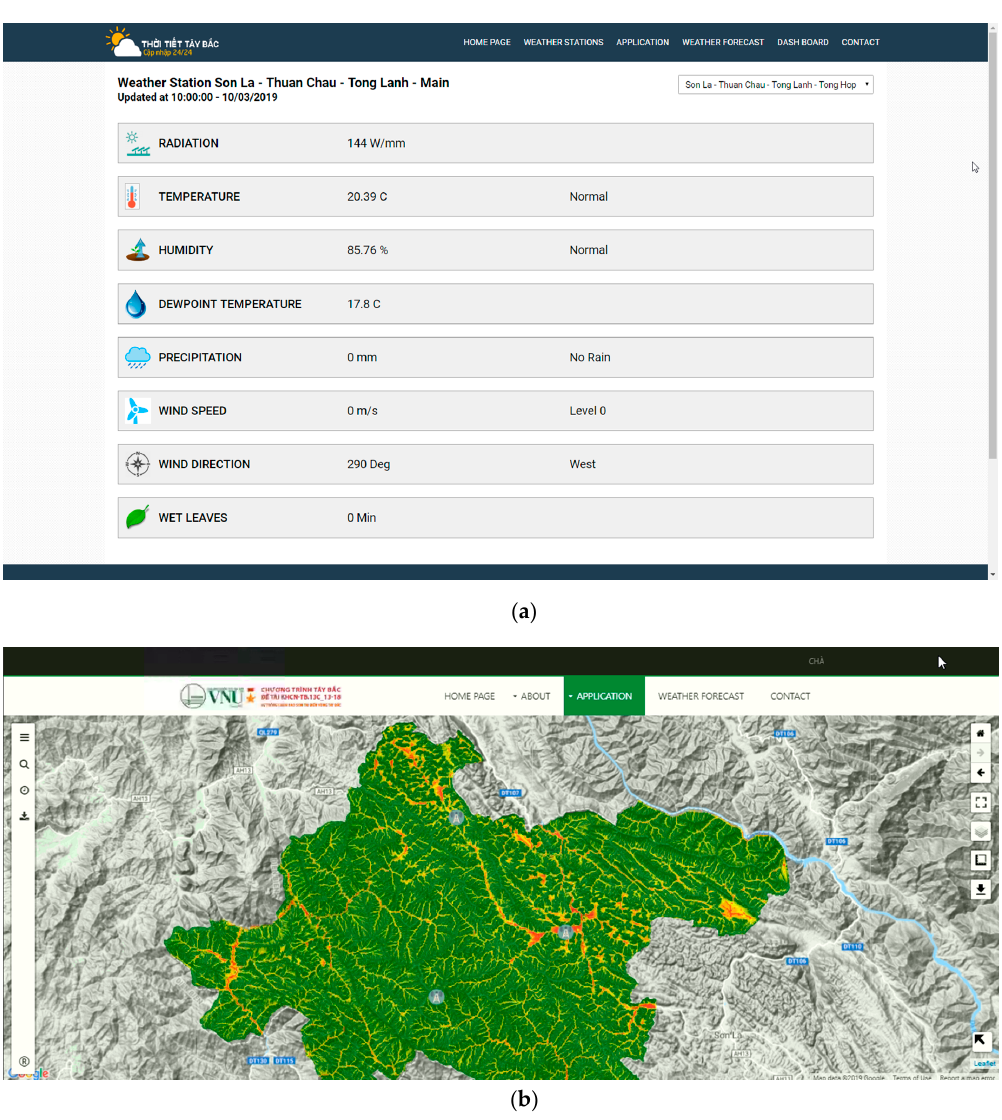
Figure 8. Generalized model and key features of flash flood warning software.